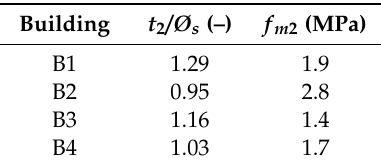
Table 6. Mortar compressive strength values ( f m2 ) determined based on the DPT test with consideration of Equation (2).